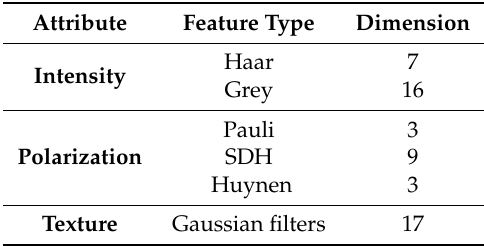
Table 1. Three types of features are extracted for the